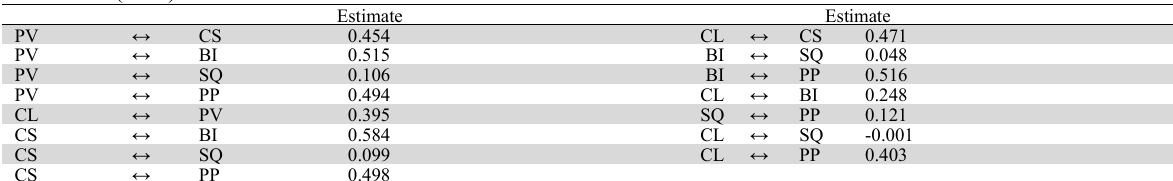
Correlation (CFA)